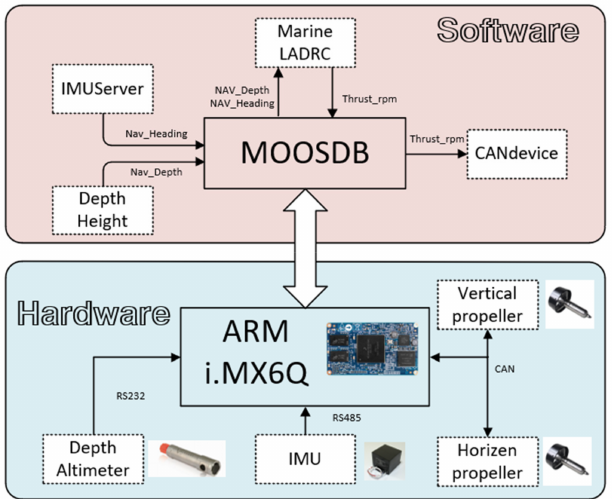
Figure 4. Control software and hardware structures of the